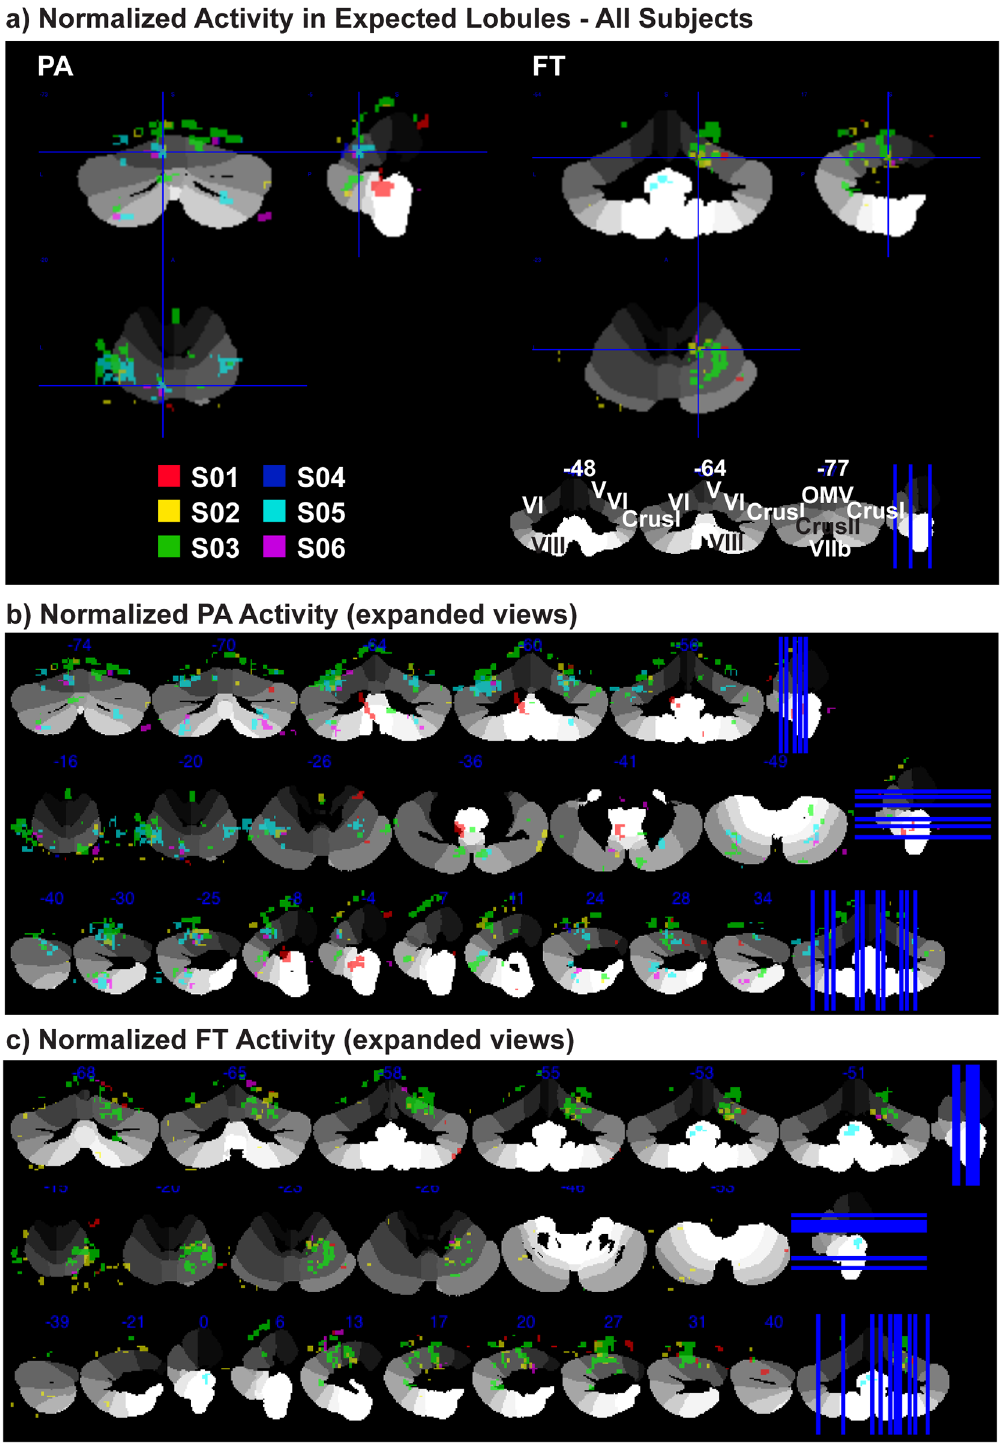
Fig 8. Inter-Subject Variability of Normalized Cb Activations. a) left — Normalized PA-activity, crosshairs at left paravermis VI; right — normalized FT- activity, crosshairs at ipsilateral (right) V; data are from all subjects, each subject is color-coded. b) PA activity is localized to oculomotor vermis (VIc and VII), bilateral h VI, and (right) h CrusI/II for all subjects. c) FT-activity in ipsilateral h V/VI for all subjects and ventral activity only for S01, S02 and S05. Activations from both tasks are clustered within the expected lobules yet inter-subject activations rarely overlap. Activations are T-maps from SUIT normalized functional images with Cb mask overlaid on SUIT template Cb [20]. Each subject is represented by a single color cluster-thresholded at p < .05 (AT).